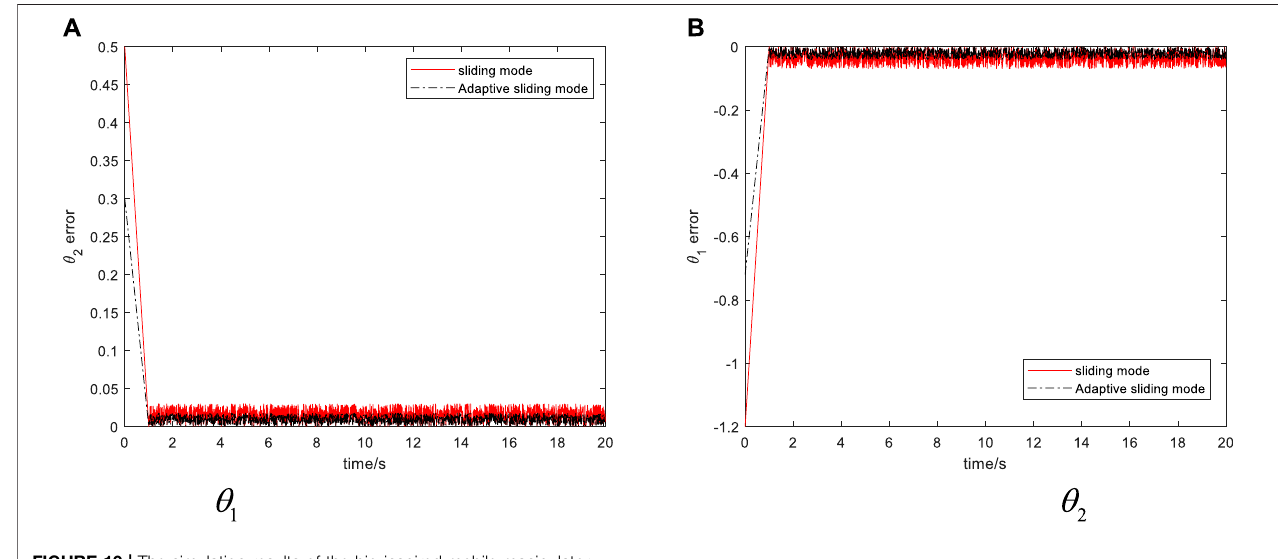
FIGURE 10 | The simulation results of the bio-inspired mobile